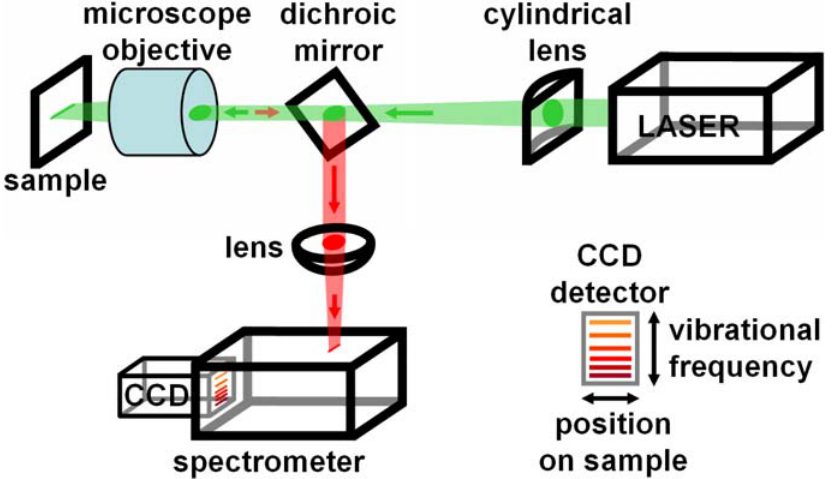
Figure 1. Schematic of Raman spectrometer. The displayed set-up focuses the illuminating laser (coloured green) down to a line on the sample (slit scanning mode), which can be replaced by a spot by removing the cylindrical lens. When a spot is illuminated at the sample, the Raman-shifted light (colored red) is filtered out from the laser light by a dichroic mirror, and dispersed along a vertical line on the two dimensional CCD detector. In slit-scanning mode, many spectra are acquired simultaneously: each position along the line on the sample produces a spectrum along the CCD